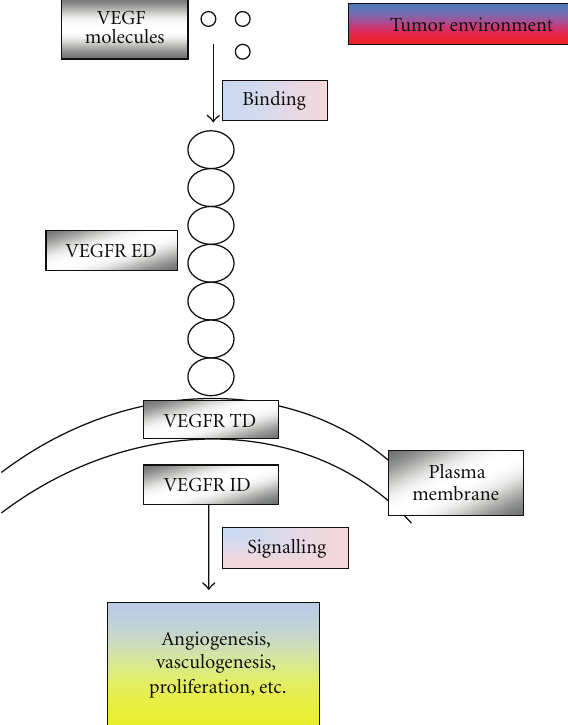
Figure 1: VEGF exerts its signalling e ff ect via its receptor VEGFR. VEGF, mainly the VGEFA isoform exerts its e ff ects via binding its receptor VEGFR (mainly VEGFR2). It is a powerful angiogenic factor that holds a pivotal role in tumor progress and metastasis. It comprises an attractive target for possible agents that will block its function and therefore enhance patients’ survival. ID: Intracellular domain, ED: extracellular domain, TD: Transmembrane